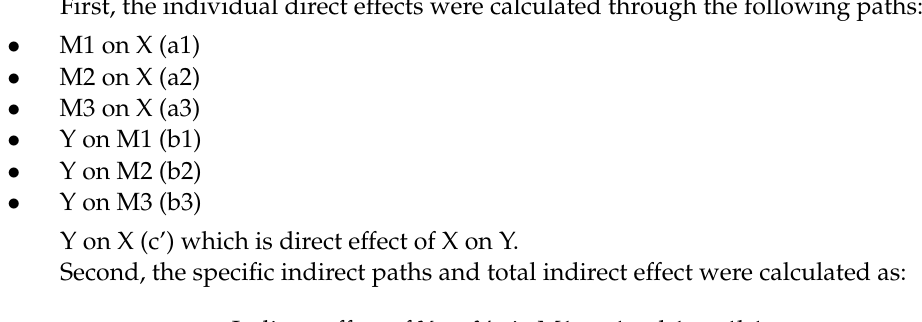
Figure 2. Hypothesized model.